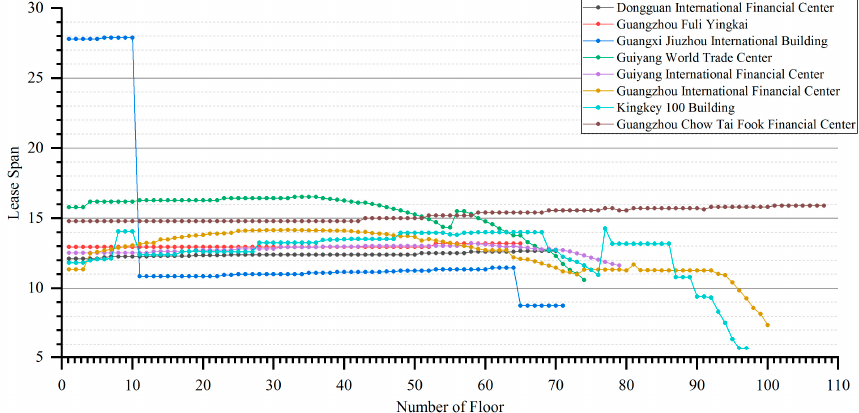
Figure 11. Variation of the lease span of the typical floor.